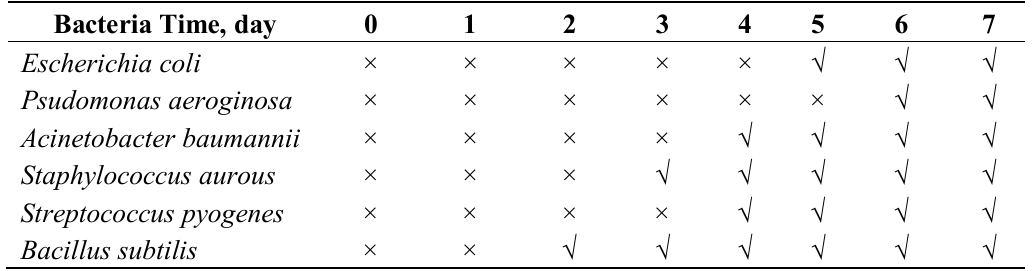
Table 3. Re-growth of bacteria in sterilized